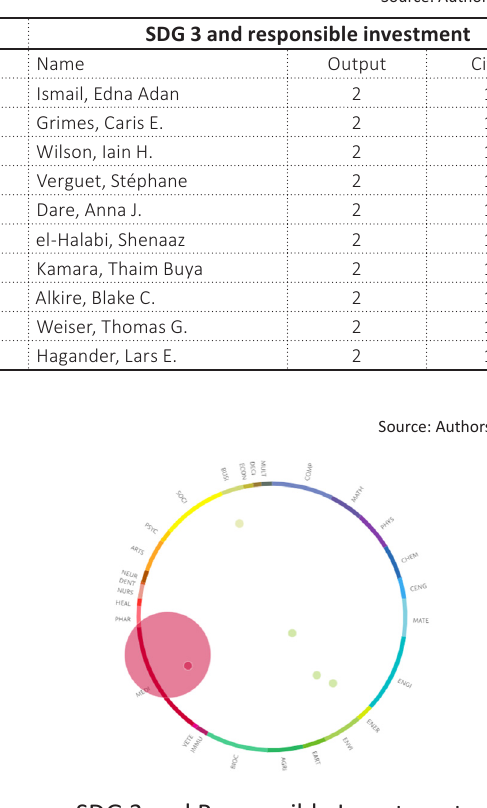
Table C1. Top 10 authors by scholarly output and citation in each research area, 2010–2019